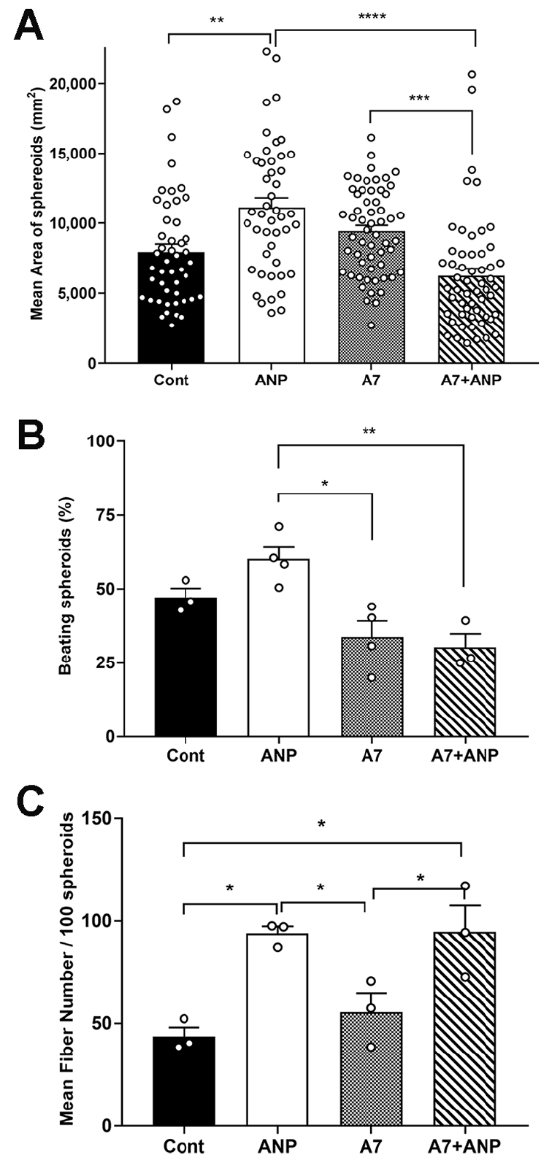
Figure 2. The effect of exogenous ANP (1 µ g/mL) and or NPRA inhibitor, A71915 (A7; 1 µ M) on 3-D cultures of E11.5 ventricular cells treated for 8 days. ( A ) Quantification of the mean areas of spheroid cell bodies, N = 3 independent experiments, 120–150 spheroid cell bodies for each group were assessed from all three experiments. ( B ) Percentage of beating spheroid cell bodies, N = 3–4 independent experiments, 9–12 random fields for each group were assessed from all three experiments. ( C ) Mean fiber numbers in 3-D cultures. N = 3 independent experiments, 100 spheroid cell bodies for each group were assessed from all three experiments. Panels A–C: Each bar represents mean ± SEM. Open circles represent individual data points for each group. * p < 0.05, ** p < 0.005,*** p < 0.0005 and **** p < 0.0001 for indicated group comparisons, One-way ANOVA with Tukey’s post hoc